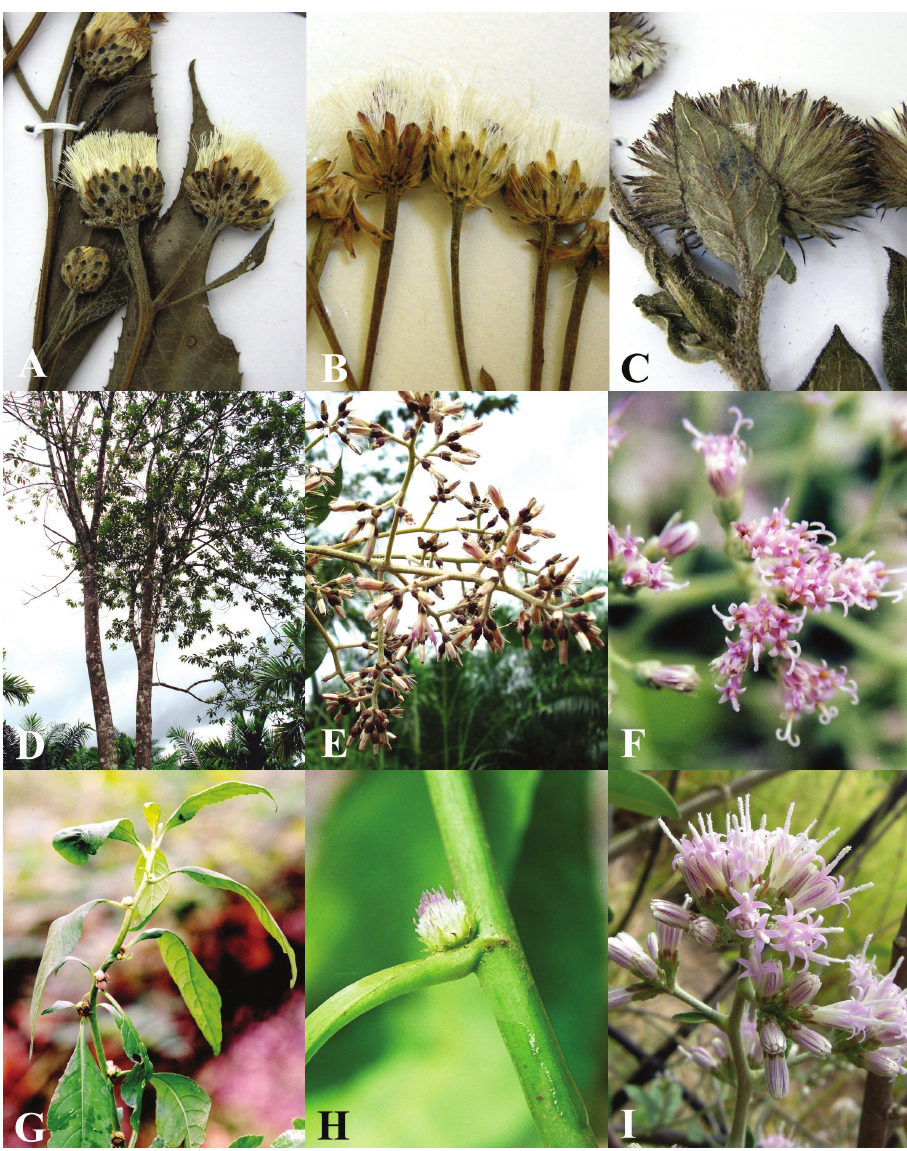
Figure 10. Morphology of Vernonieae in Thailand 6. A Okia birmanica B Okia pseudobirmanica C Pu- licarioidea annamica D–E Strobocalyx arborea F Strobocalyx solanifolia G–H Struchium sparganophorum I Tarlmounia elliptica